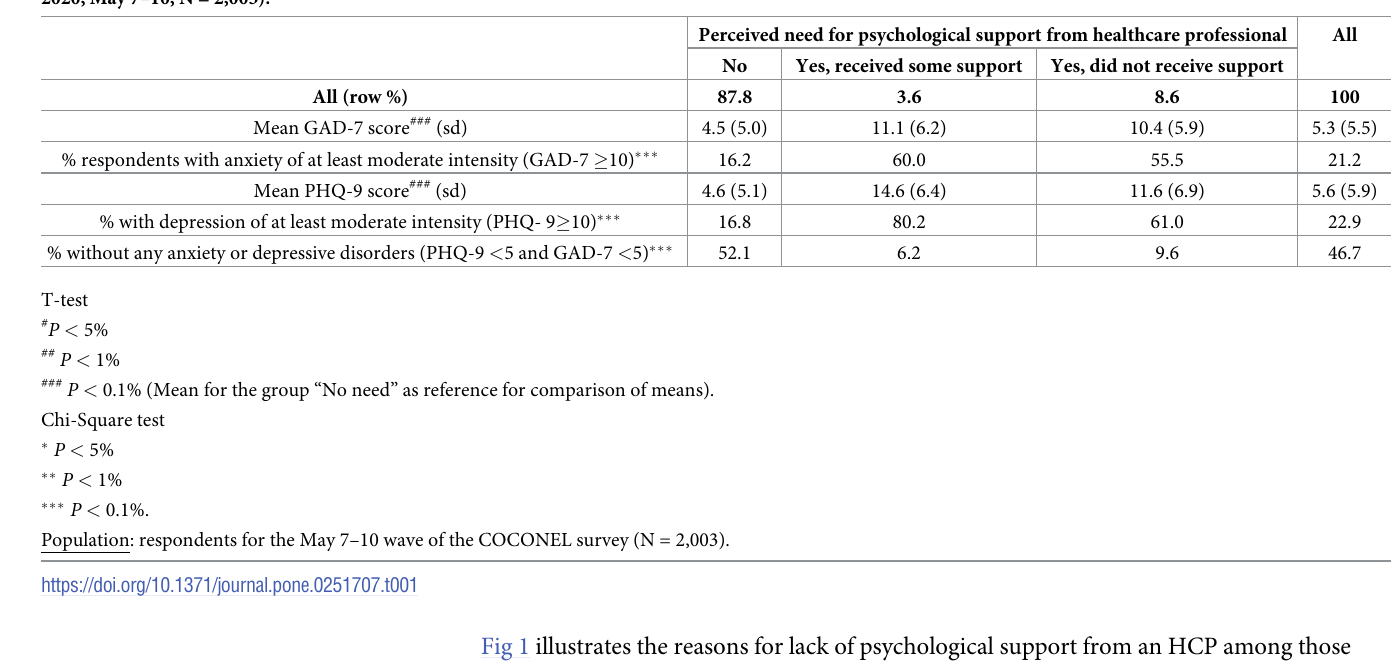
Fig 1 illustrates the reasons for lack of psychological support from an HCP among those who felt they needed but did not receive it: half of them (50.7%, 4.4% of the entire sample) chose to forgo care because they did not want to take the risk of COVID-19 infection to protect themselves or their families. Moreover, 40.4% (3.5% of the entire sample) chose not to consult